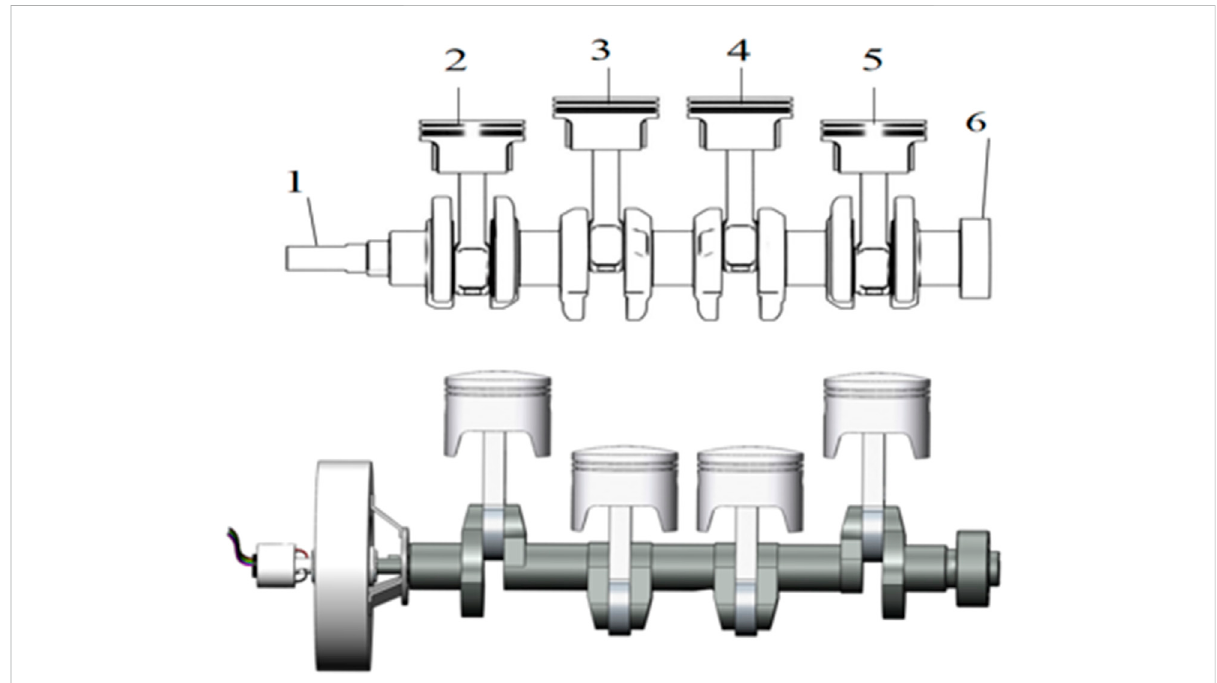
FIGURE 5 Schematic diagram of the crankshaft system (top). Schematic diagram of the crankshaft system with MR damper installed (bottom). 1. Free end of crankshaft 2. First cylinder piston 3. Second cylinder piston 4. Third cylinder piston 5. Fourth cylinder piston 6. Flywheel.